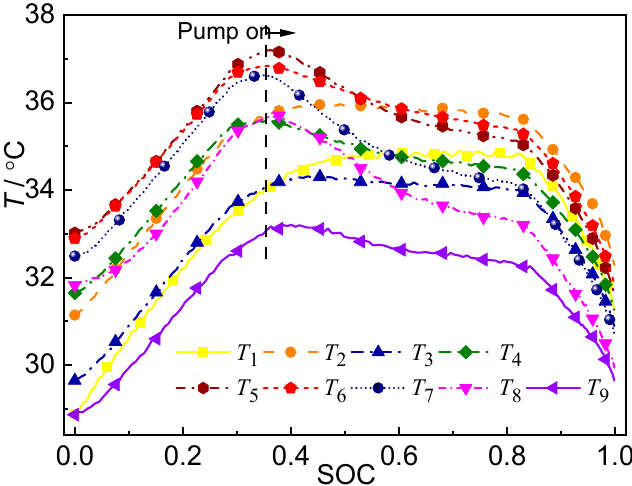
Figure 6. Evolution of the battery pack temperature when the battery module was charging at 0.5 °C, the pump runs at 50 Hz with a large initial temperature difference.